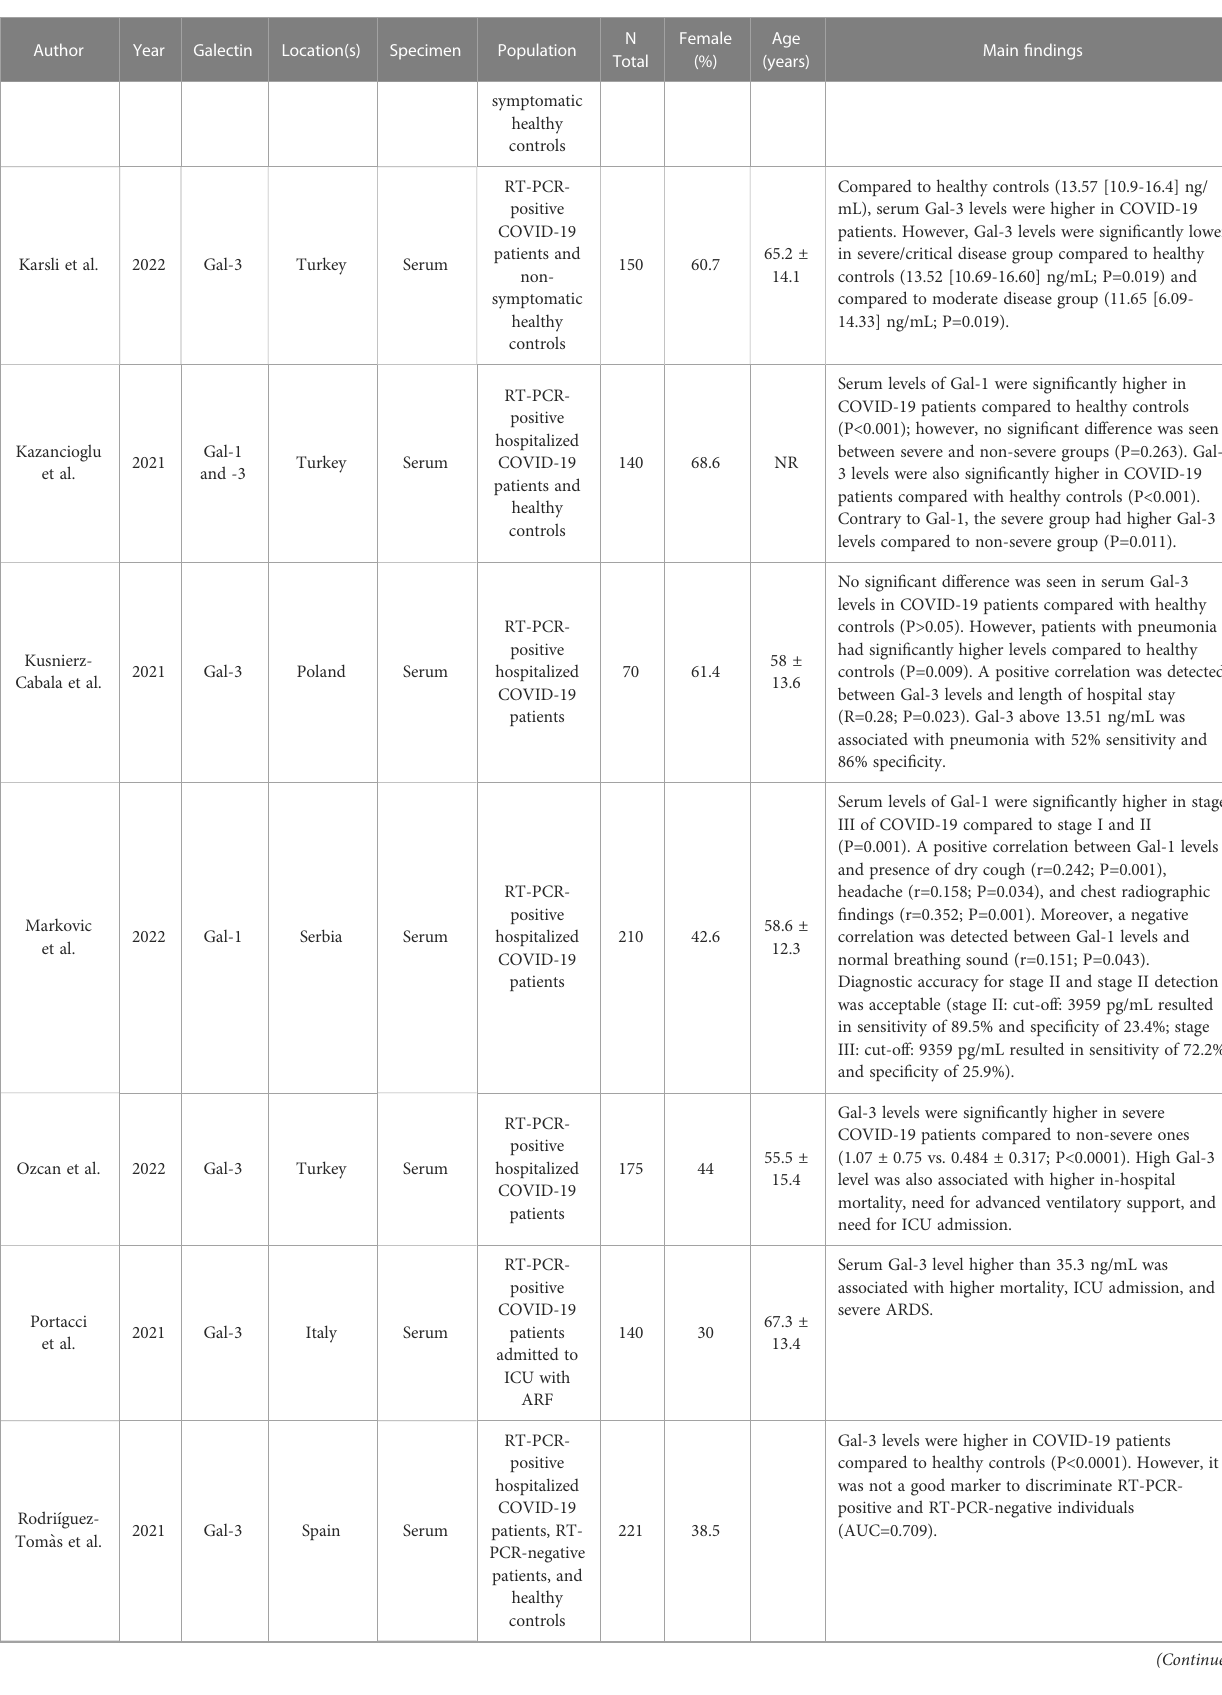
Compared to healthy controls (13.57 [10.9-16.4] ng/ mL), serum Gal-3 levels were higher in COVID-19 patients. However, Gal-3 levels were signi fi cantly lower in severe/critical disease group compared to healthy controls (13.52 [10.69-16.60] ng/mL; P=0.019) and compared to moderate disease group (11.65 [6.09- 14.33] ng/mL; P=0.019).